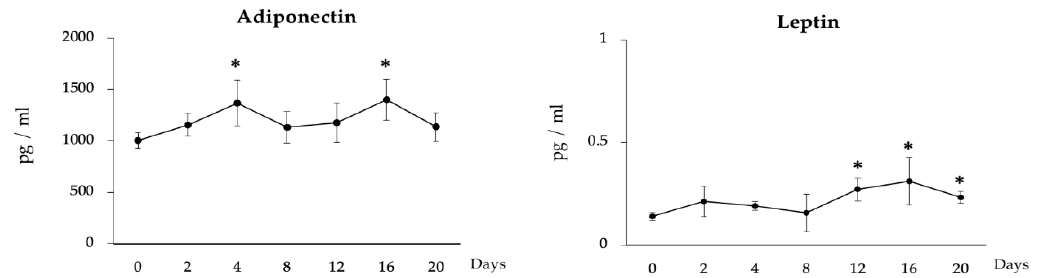
Figure 5. Long-term adipogenic differentiation mediated secretion of adiponectin and leptin in adipocytes. The ELISA-based quantification of adiponectin and leptin concentration in adipocytes as measured over the 20 days of culture. Data shown are the mean ± SD of three independent experiments performed in triplicates. The asterisk (*) indicated the statistical differences of protein concentration when compared with day 0, at the significance level of p < 0.05.